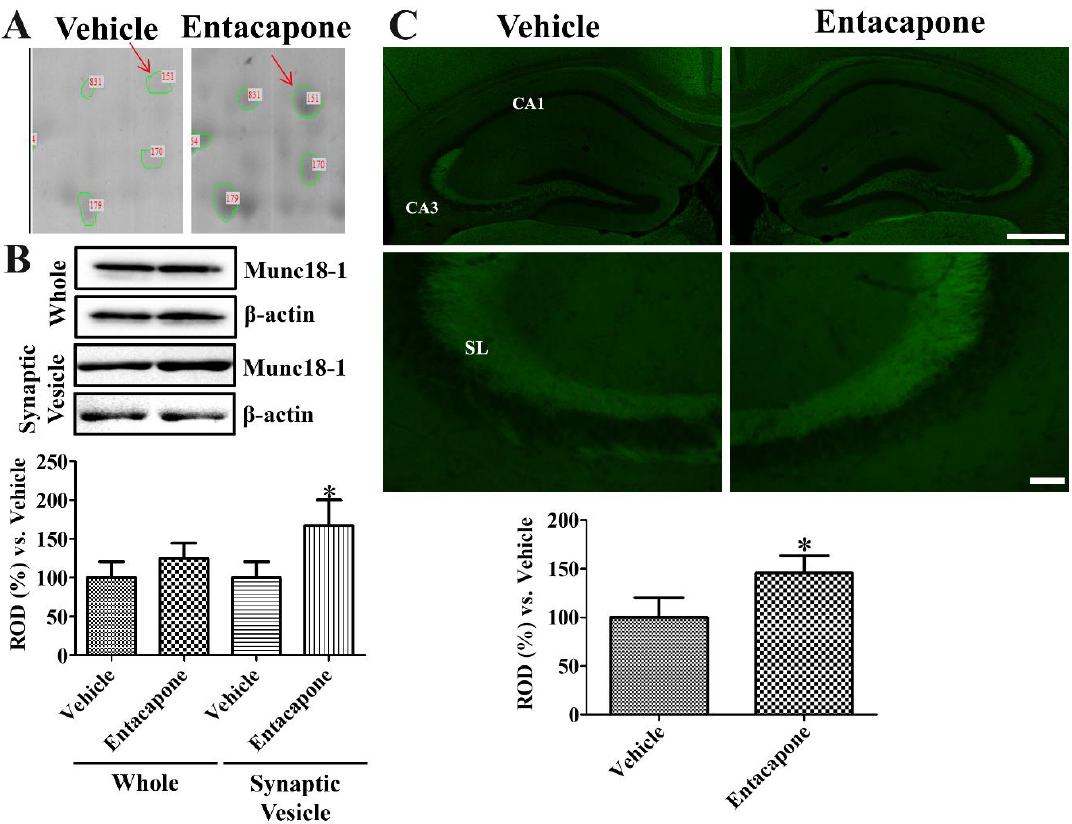
Figure 4. Munc18-1 expression in the hippocampus of vehicle- and entacapone-treated groups based on proteomic ( A ), western blot ( B ), and immunohistochemical ( C ) study. Munc18-1 was detected in a single spot. Munc18-1 protein levels were not significantly different between the hippocampi of vehicle- and entacapone-treated groups, while protein levels are significantly increased in the synaptic vesicle fraction of entacapone-treated group compared to that in the control group. Relative optical density in the entacapone-treated group versus that in the vehicle-treated group is shown in percentages for western blot analysis (* p < 0.05, significantly different from the vehicle-treated group). Western blot assays were performed in at least triplicate and bar graph represents the mean ± standard deviation. Munc18-1 immunoreactivity is observed in the stratum lucidum (SL) of CA3 region. Scale bar = 400 μm (low magnification), 50 μm (high magnification). Three sections , 150 μm apart, are selected between 1.7 and 2.3 mm caudal to the bregma in each animal. Relative optical densities (ROD) are expressed as a percentage of the value of Munc18-1 protein levels and immunoreactivity in the vehicle-treated group ( n = 5 in each group; * p < 0.05, significantly different from the vehicle-treated group). The bars indicate the mean values ± standard deviation.